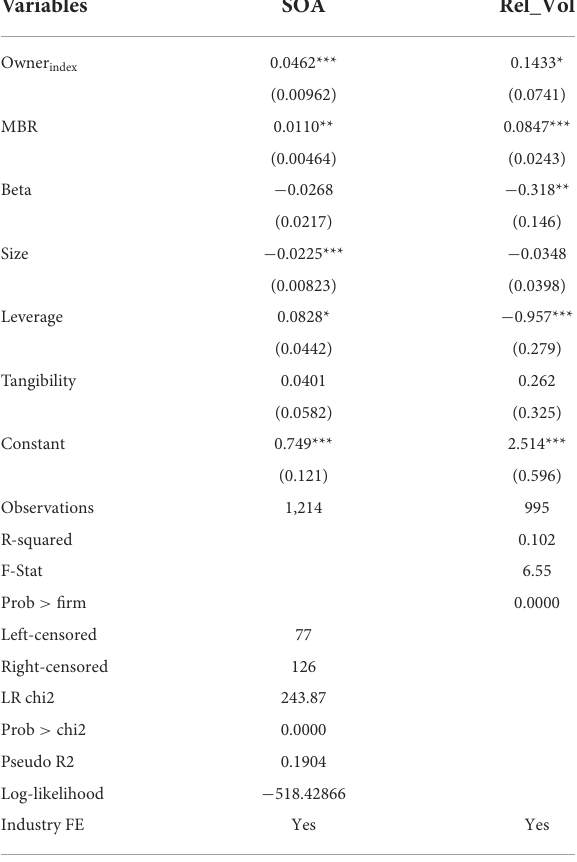
TABLE 8 Ownership index and dividend smoothing. TABLE 9 Ownership structure and asymmetric dividend